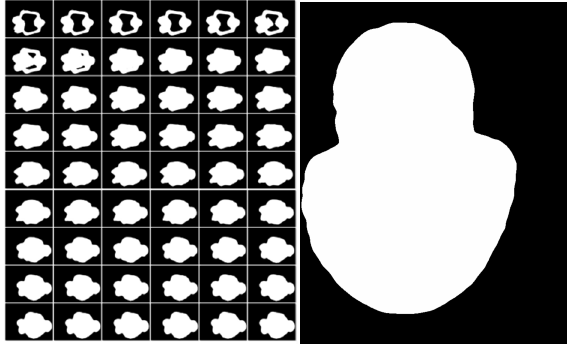
Figure 3. Binary image in frame buffer.